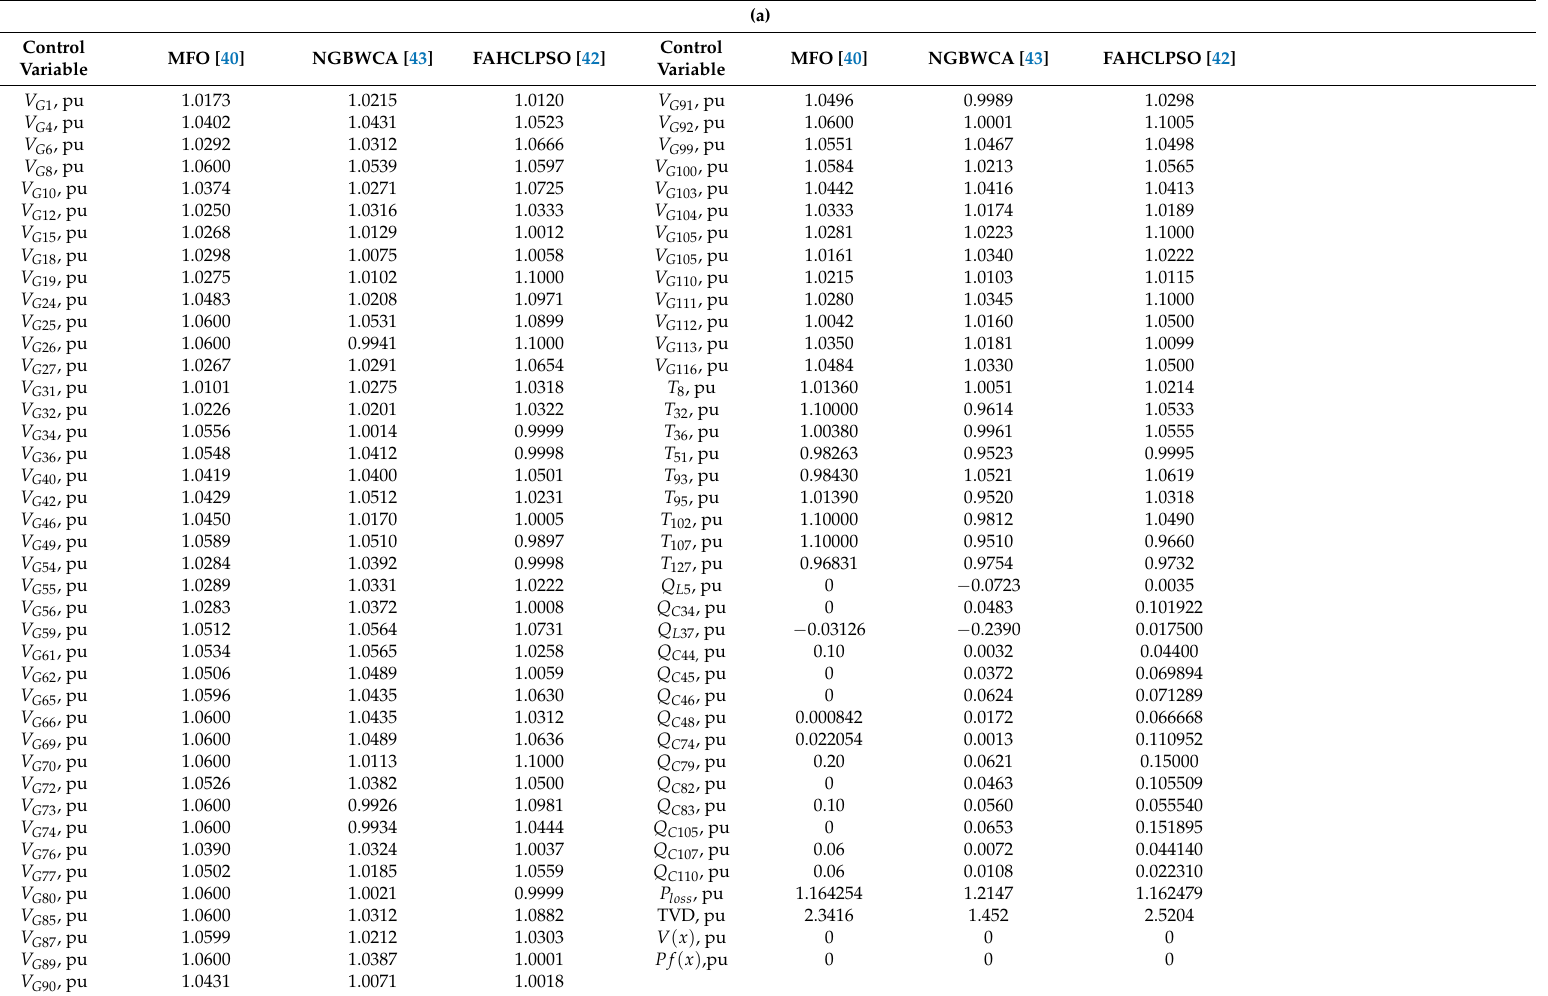
Table 7. Best control variable settings for power loss minimization of IEEE 118 bus test system with different